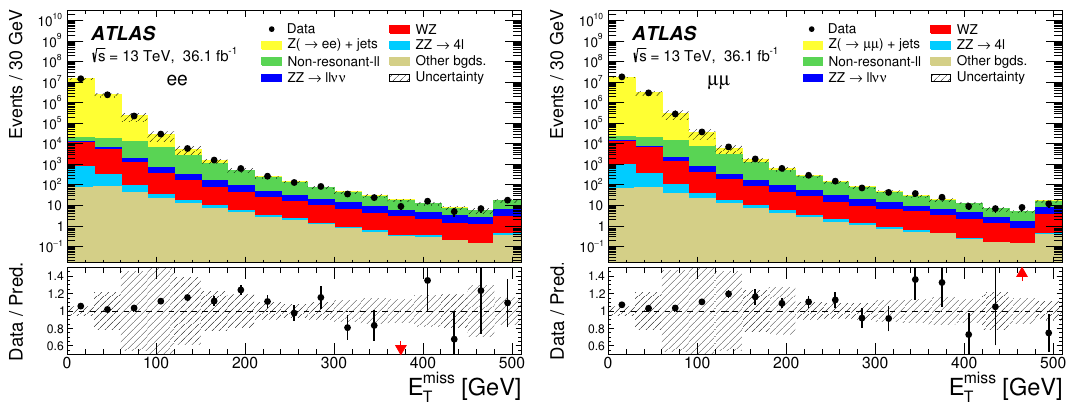
Figure 2 . The E miss distributions after the preselection for the ee (left) and (cid:22)(cid:22) (right) channels. T The expectation is derived from simulation and the hashed band accounts for the statistical and experimental uncertainties. The experimental uncertainties are described in section 7. The last bin in the distributions contains the over(cid:13)ow events. The arrows indicate that the di(cid:11)erences between the data and the expectation in some bins exceed the y -axis scope of the bottom plots. The \other" background corresponds to the V V V and t (cid:22) tV